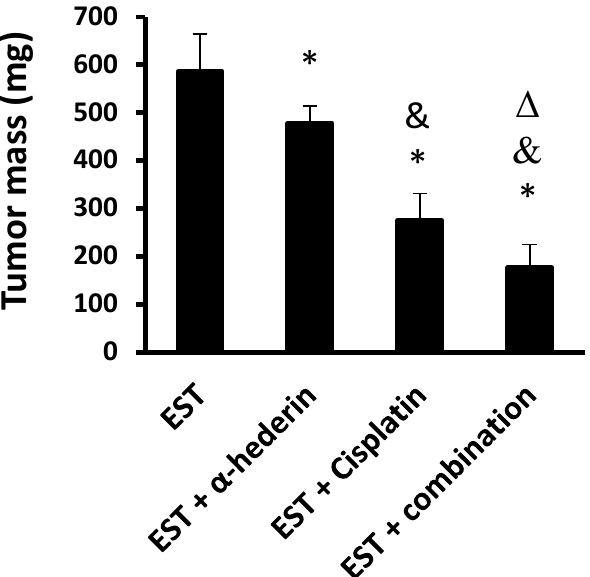
Figure 1. Effect of α -hederin and cisplatin on solid tumor masses. EST: Ehrlich solid tumors. Data are mean ± SD, *: versus EST control group, &: versus EST + α -hederin group, ∆ : versus EST + cisplatin group at p < 0.05.